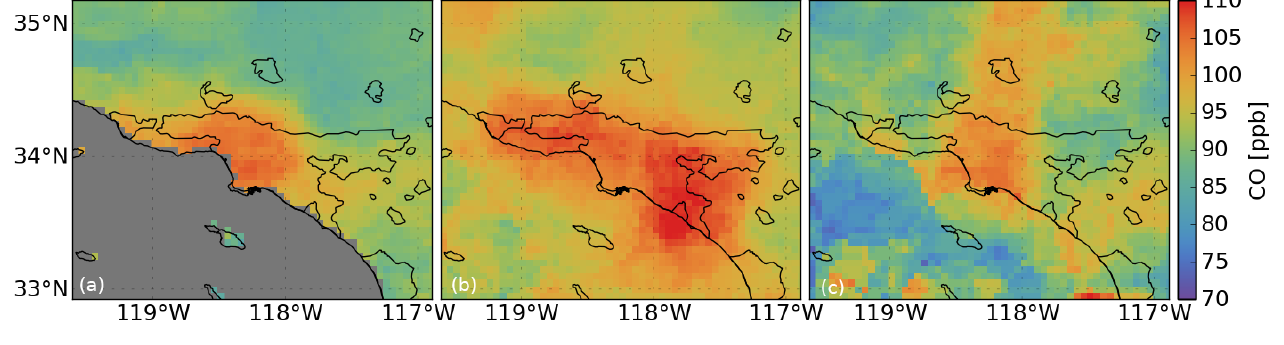
Figure 9. Same as Fig. 7 but for Los Angeles.